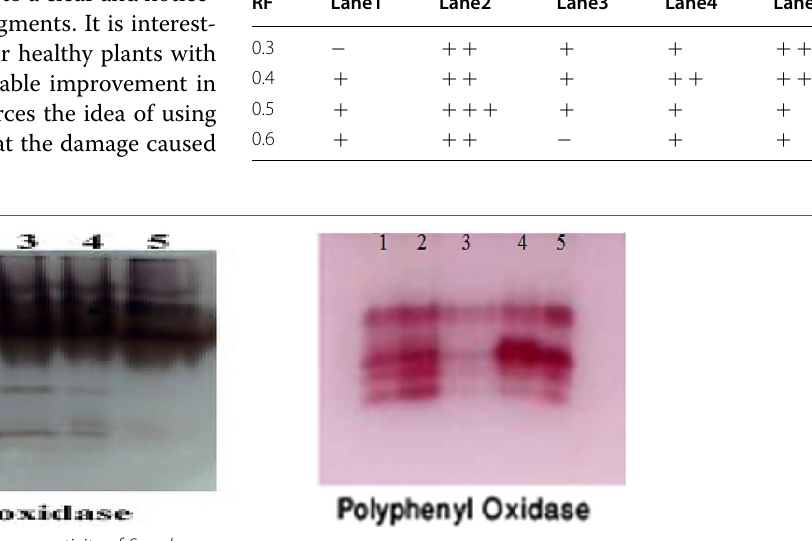
Fig. 7 Effect of A . terreus on antioxidant isozymes activity of S. melongena